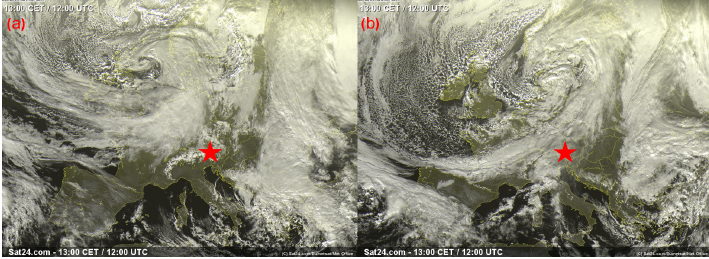
Figure A5. Visible satellite image of the storm system impacting the SBO (red star), taken at 12:00UTC on (a) 27 November and (b) 28 November. Images courtesy of sat24, EUMETSAT, and the Met Office (http://www.sat24.com/history.aspx, last access: 22 March 2019).